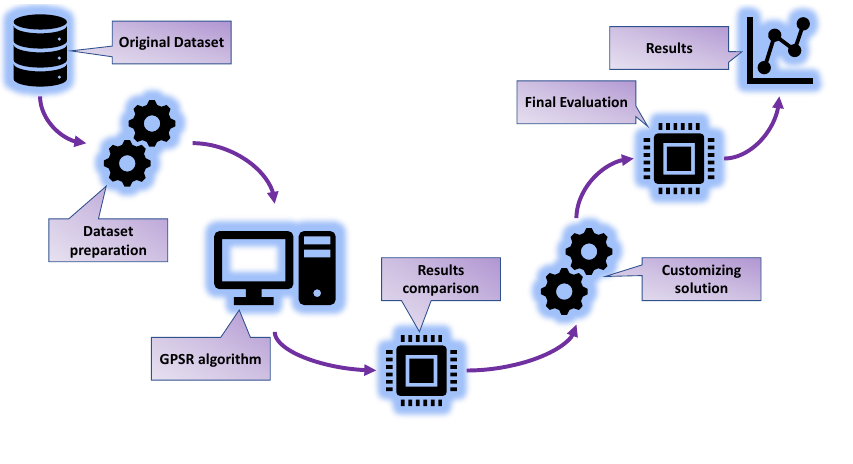
Figure 4. The flow chart of the research